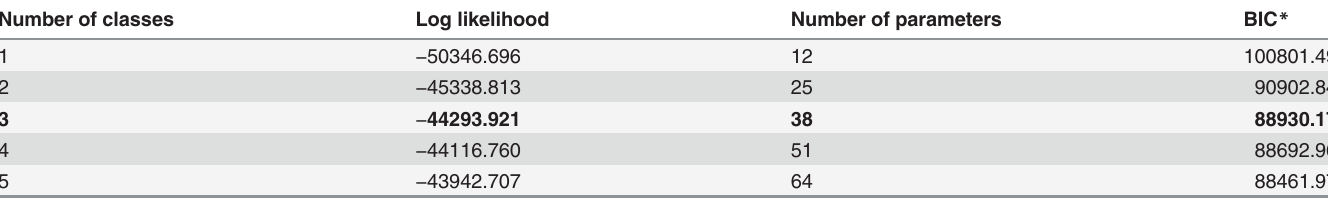
Table 1. Latent class analysis for socioeconomic circumstances at 12 years of age.